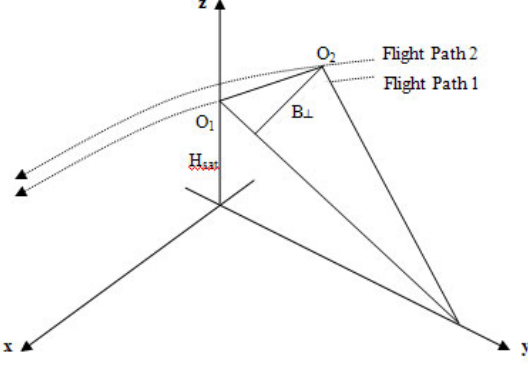
Figure 10. Baseline length is the temporal and spatial distance between two satellite observations Perpendicular Baseline ( 𝐵 ! ) is the spatial distance between the first and second observations measured perpendicular to the look direction. It gives an indication of the sensitivity to topographic height, the amount of decorrelation due to phase gradients, and the effectiveness of the phase unwrapping. The longer 𝐵 ! , the weaker the coherency and the lower the sensitivity to height changes (Hanssen, R.). Temporal